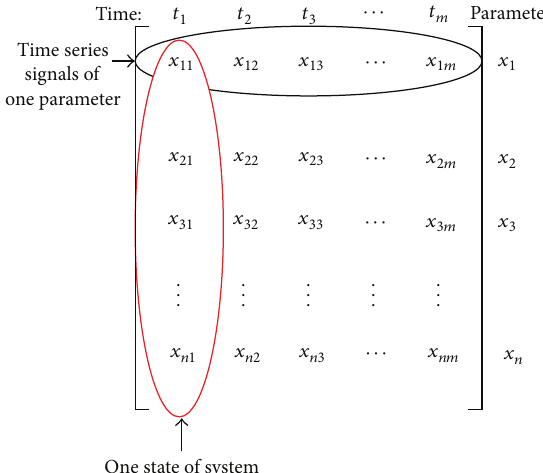
Figure 3: Actual in-orbit telemetry data matrix in MSET